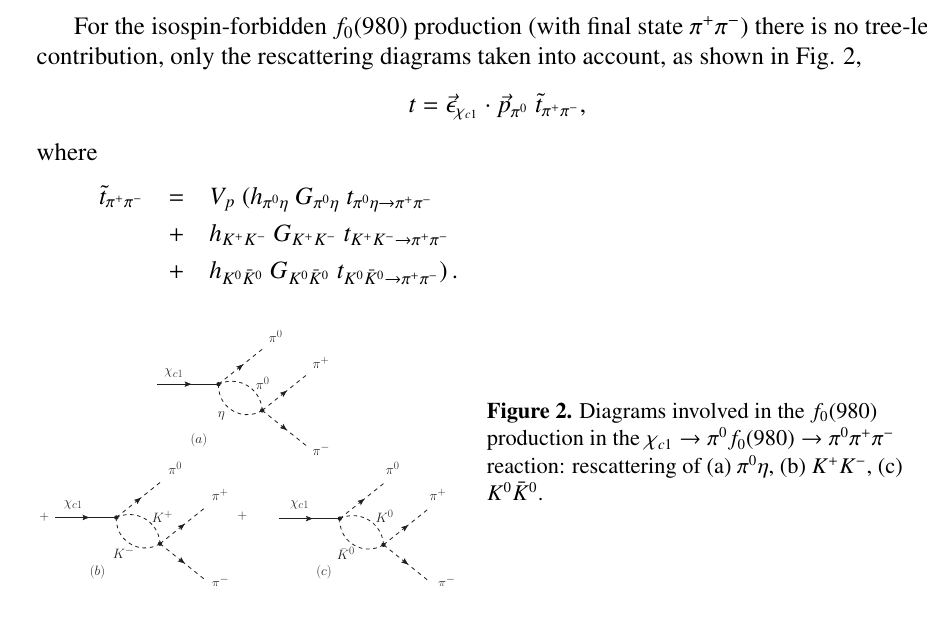
Figure 1. Diagrams involved in the a 0 (980) production in the χ c 1 → π 0 a 0 (980) → π 0 π 0 η reaction: (a) tree-level; and rescattering of (b) π 0 η , (c) K + K − , (d) K 0 ¯ K 0 .